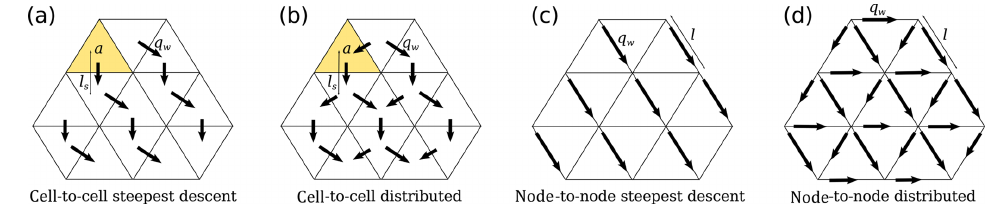
Figure 2. Diagram of flow routing from cell to cell and node to node for either a single flow direction (SFD) or a multiple flow direction (MFD) algorithm weighted by the relative